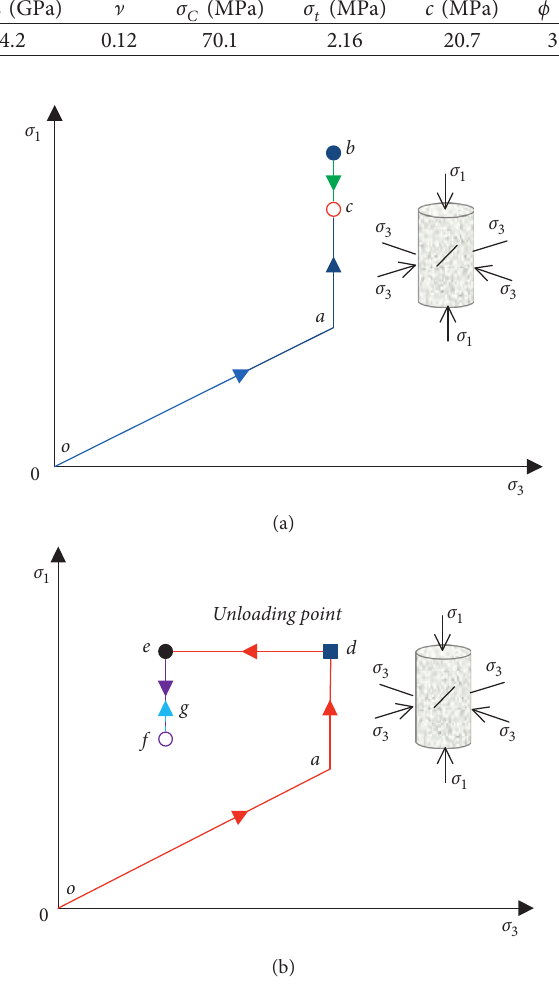
Figure 5: Loading paths of the type I and II tests (after Yang et al. [33]). (a) Type I: conventional triaxial compression. (b) Type II: triaxial compression with prepeak circumferential